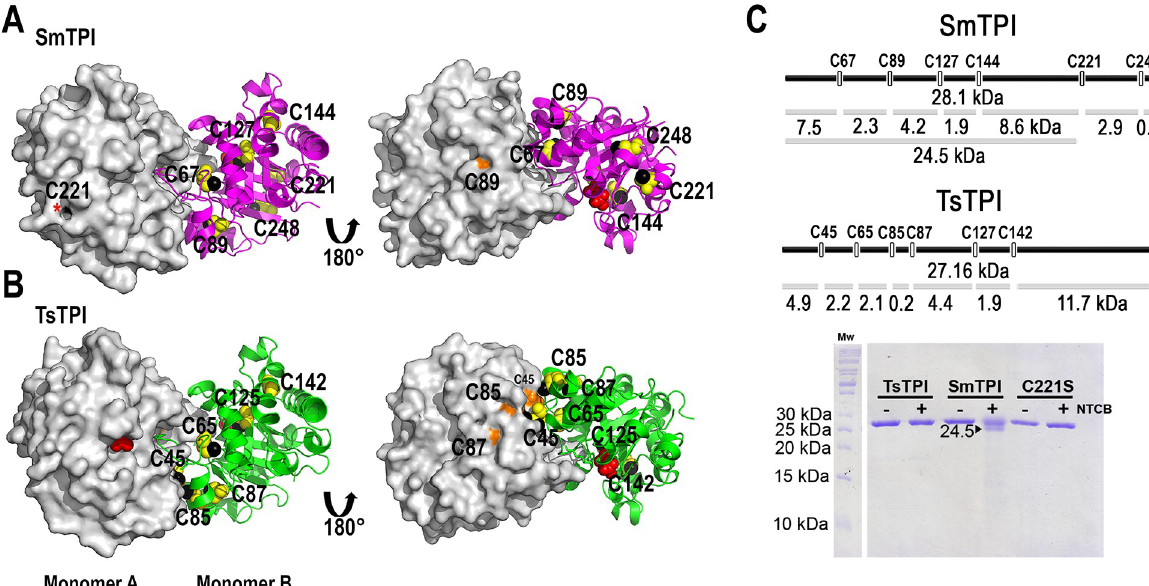
Fig 6. Crystal structure of SmTPI and TsTPI showing their cysteine residues. A and B) Surface and ribbon representation of SmTPI and TsTPI showing their exposed cysteines. Molecule A in both TPIs is presented as a surface representation, whereas molecule B is show as ribbons. The thiol group of each cysteine is colored in black in both molecules A and B. The rest of the atoms of the cysteines are colored in orange for molecule A and yellow for molecule B, respectively. The thiol group of residue SmTPI-C221 is labeled with a red asterisk. C) Predicted and experimental NTCB cleavage sites in SmTPI and TsTPI. The upper part of the panel shows the predicted NTCB cleavage sites for SmTPI and TsTPI, whereas the bottom part of the panel shows a SDS-gel with protein samples treated with NTCB. SmTPI is processed by NTCB at a single site generating a product of 24.5 kDa and this product is not present in the SmTPI-C221S mutant.